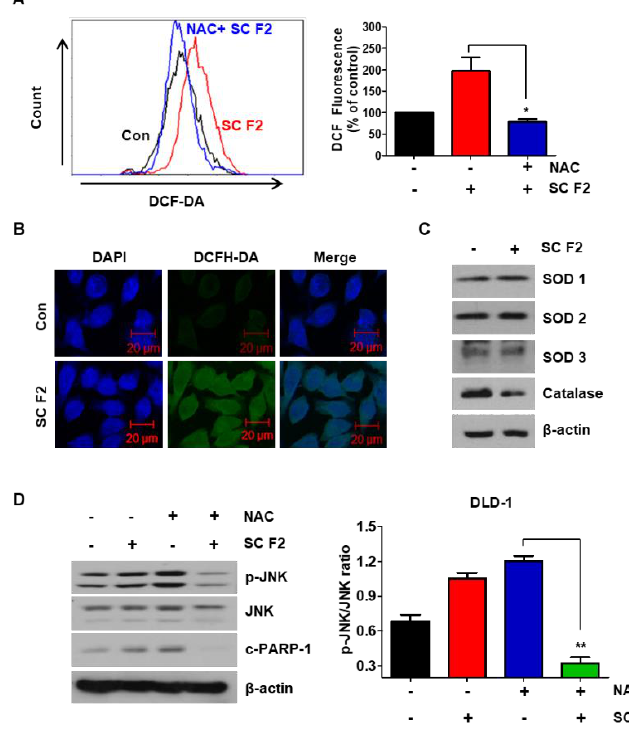
Figure 4. SC F2-induced ROS generation is mediated through selective decrease of catalase. ( A ) ROS production was assessed by DCFH-DA, following 1 h pre-treatment with 200 µ g / mL of SC F2 in DLD-1 cells. ( B ) DLD-1 cells were treated with SC F2 (200 µ g / mL) for 20 h, cells were stained with FITC probe DCFH-DA (10 µ M) for 30 min at 37 ◦ C, and visualized under a confocal microscope. ( C ) DLD-1 cells were treated with SC F2 (200 µ g / mL) for 20 h. The protein expression levels of ROS-related proteins were measured by immunoblotting using corresponding antibodies. ( D ) DLD-1 cells were pre-treated with 10 mM N -acetyl- l -cysteine (NAC) for 1 h, followed by treatment with or without SC F2 (200 µ g / mL). Cells were then lysed and subjected to Western blotting. “*” or “**” represents a statistically significant difference between untreated control cells and drug treated cells at p < 0.05 or p < 0.01, respectively.